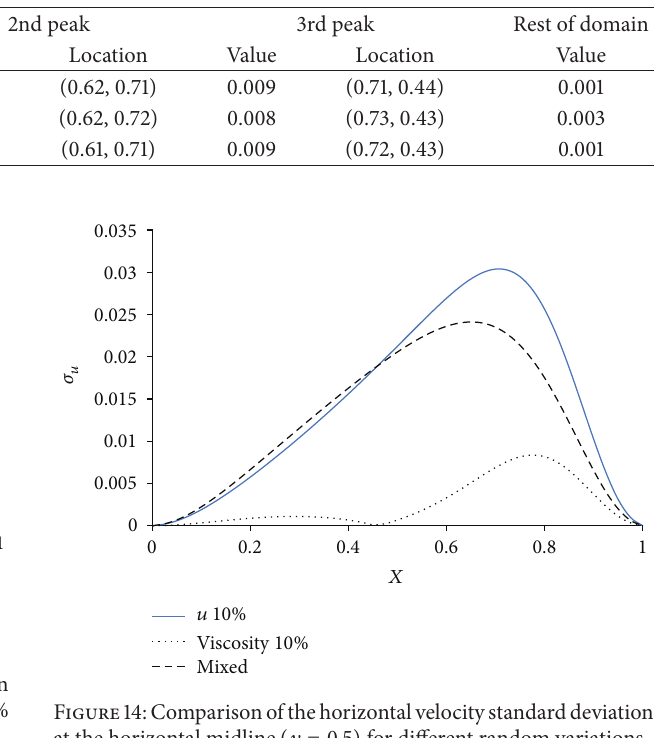
Figure 12: Standard deviation comparison of the horizontal velocity component (a) and vertical velocity component (b) along the vertical midline (𝑥 = 0.5) . Table 1: Standard deviation of horizontal velocity component (peaks from left to right).